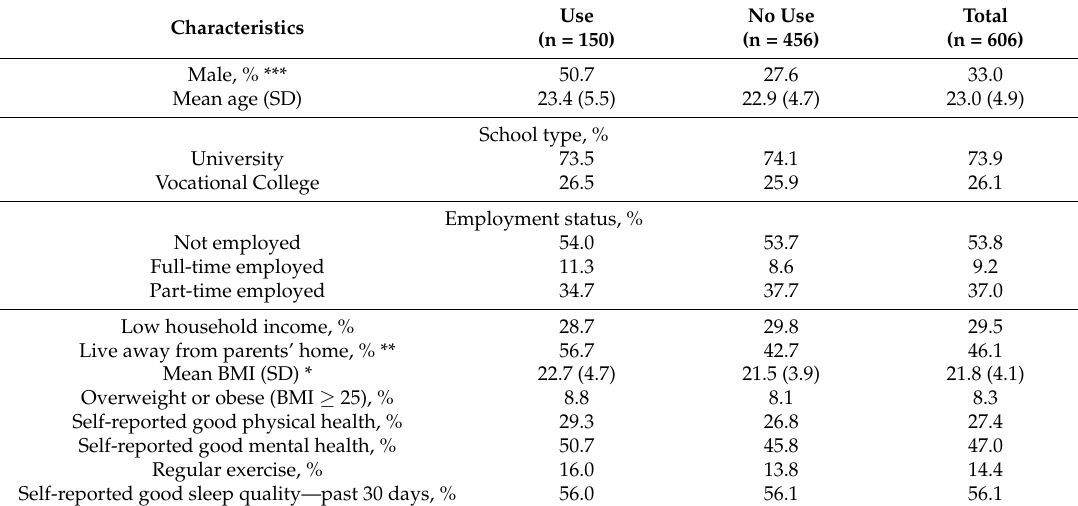
Table 1. Demographics, self-reported health, lifestyles, and substance use, by energy drink use in the past 30